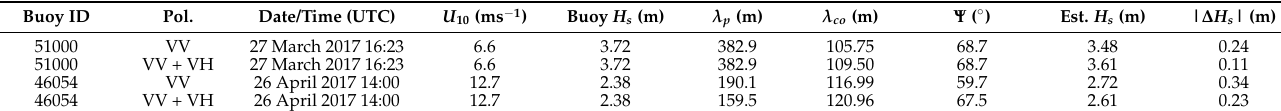
Table 2. Comparison of results between SAR images and NDBC buoy data based on the cases of Figure 2 ( ∆ H s = Est. H s − Buoy H s ).